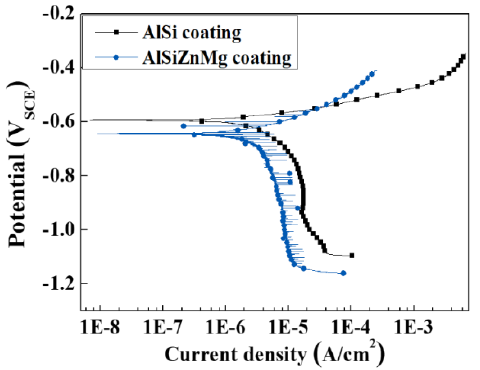
Figure 5. Potentiodynamic polarization curves of AlSi-MC and AlSiZnMg-MC, measured after 1 h immersion in a 3.5% NaCl solution [20].